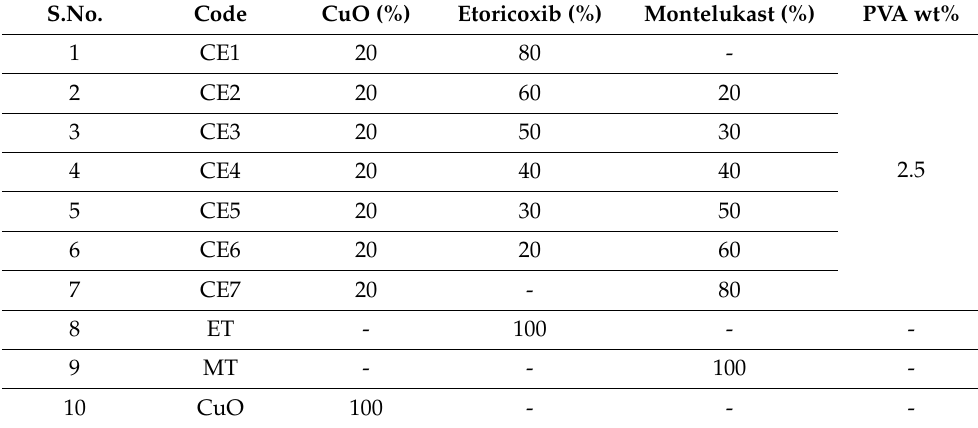
Table 7. Composition of